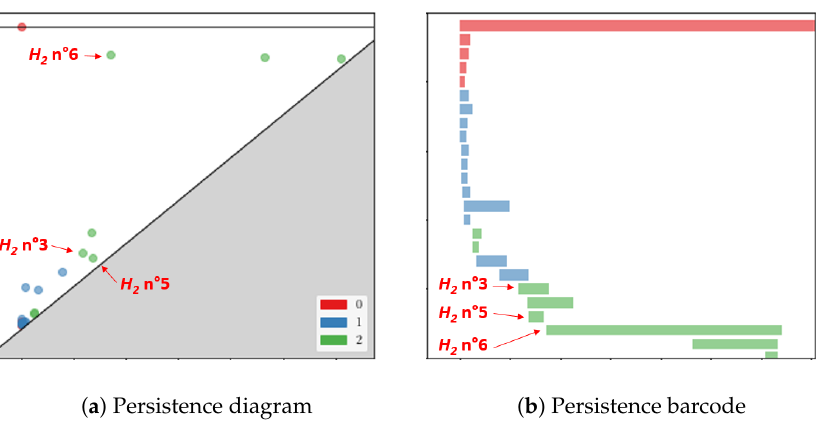
Figure 9. Persistence diagram and barcode of the anomaly of scan S2962 . Three particular homologies reflecting the anomaly are highlighted.